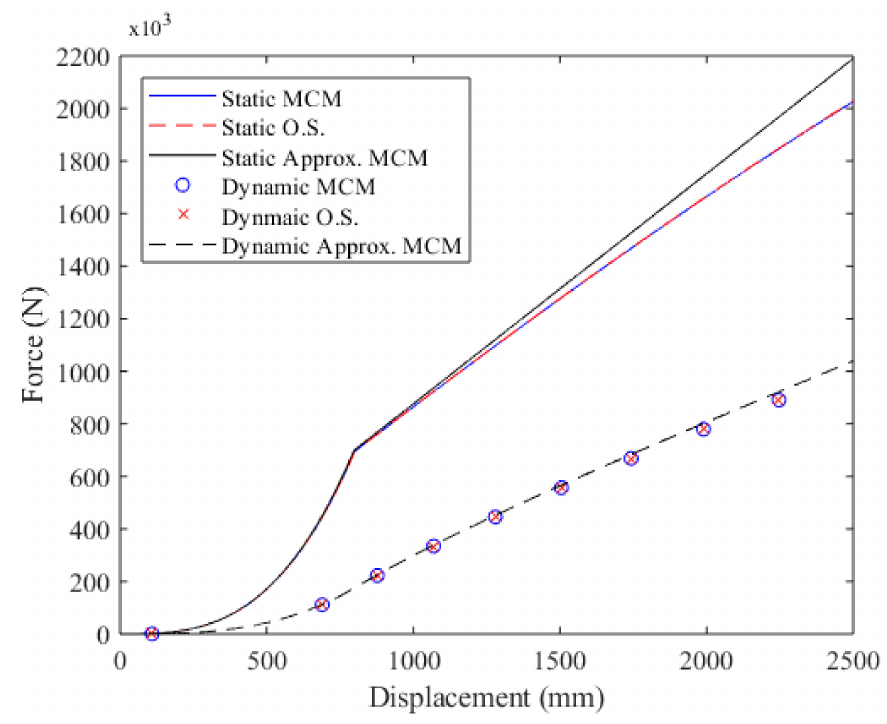
Figure 7. Analytical load-deflection results. MCM—modified catenary model.